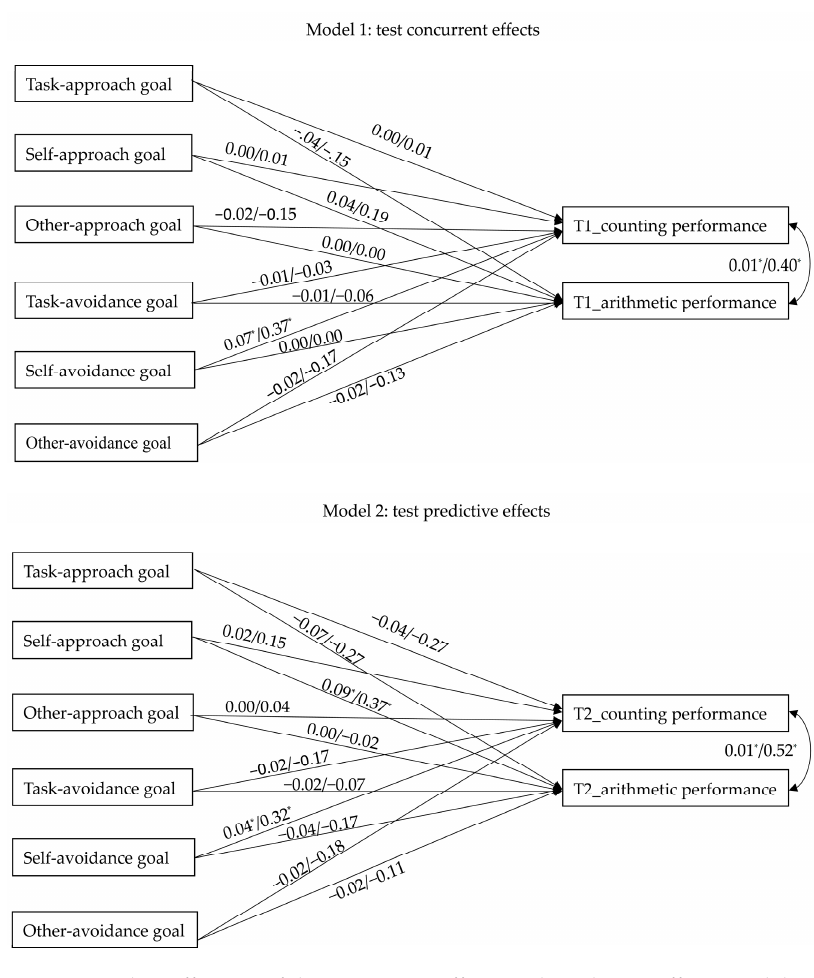
Figure 2. Path coefficients of the concurrent effects and predictive effects models. Note. unstandard- ized coefficients/completely standardized coefficients. For simplicity, intercorrelation coefficients among achievement goals are not presented in the Figure. * p < 0.05.